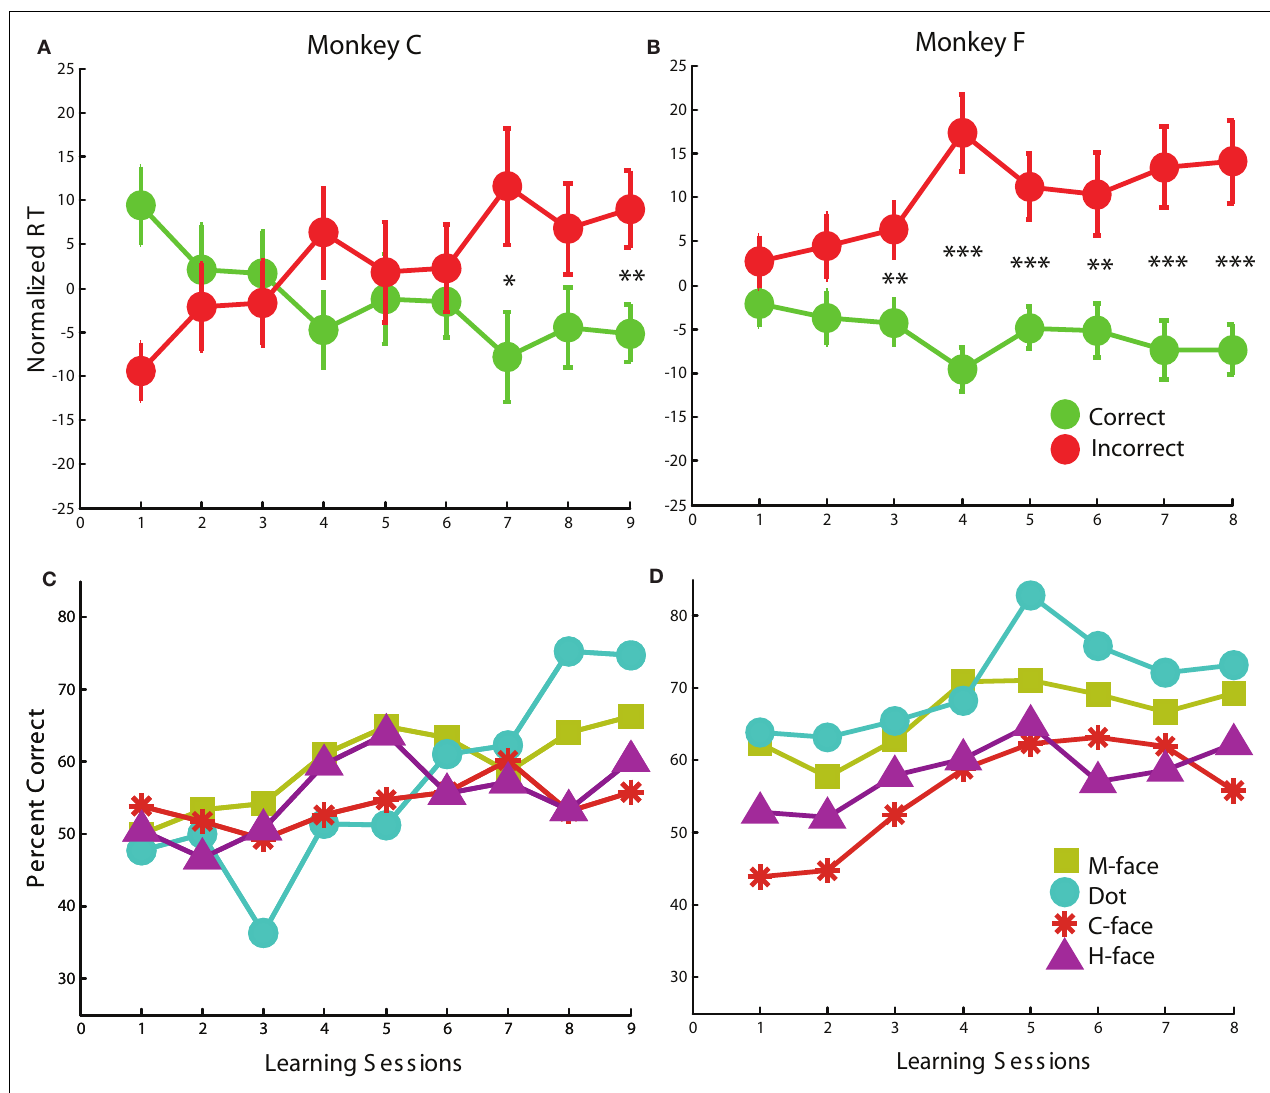
for incorrect trials) developed over the course of nine and eight learning sessions for both monkeys (* p < 0.05, ** p < 0.01, *** p < 0.001). (C,D) Accuracy improved for all stimulus categories as a function of learning sessions for both